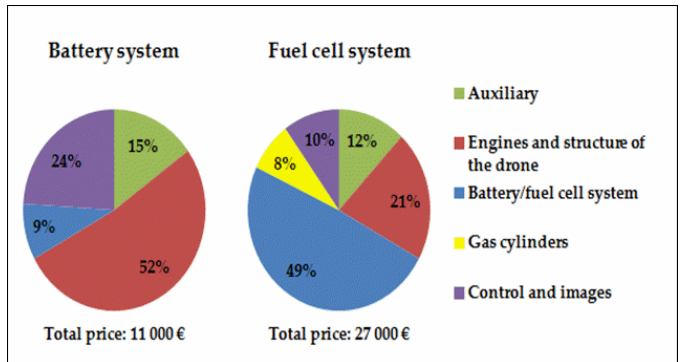
Figure 8. Total costs and cost distributions for the two alternatives of the mobile system.